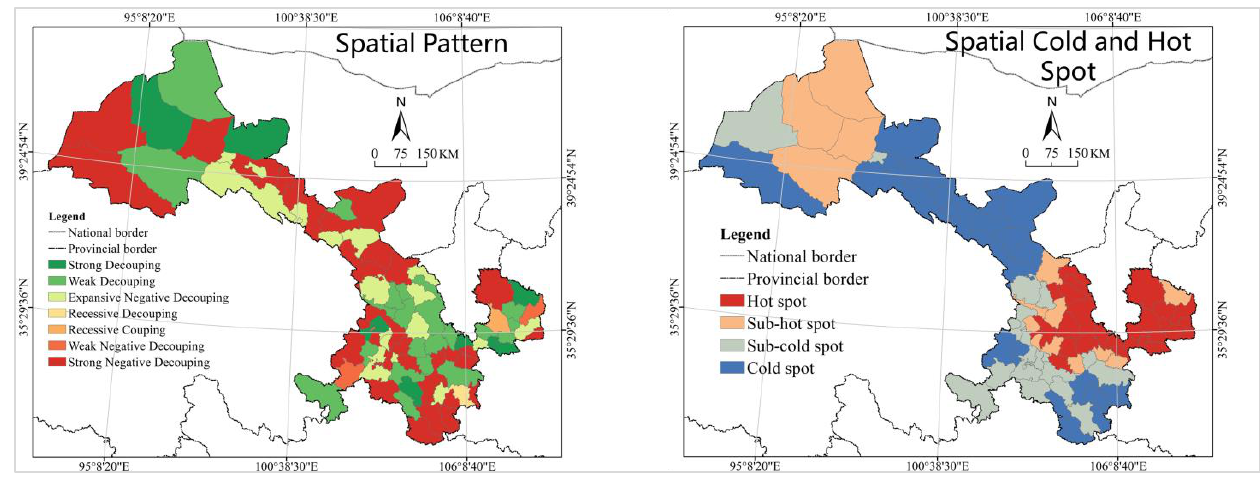
Figure 13. Spatial analysis on the decoupling relationship between urban construction land and government revenue in Gansu.